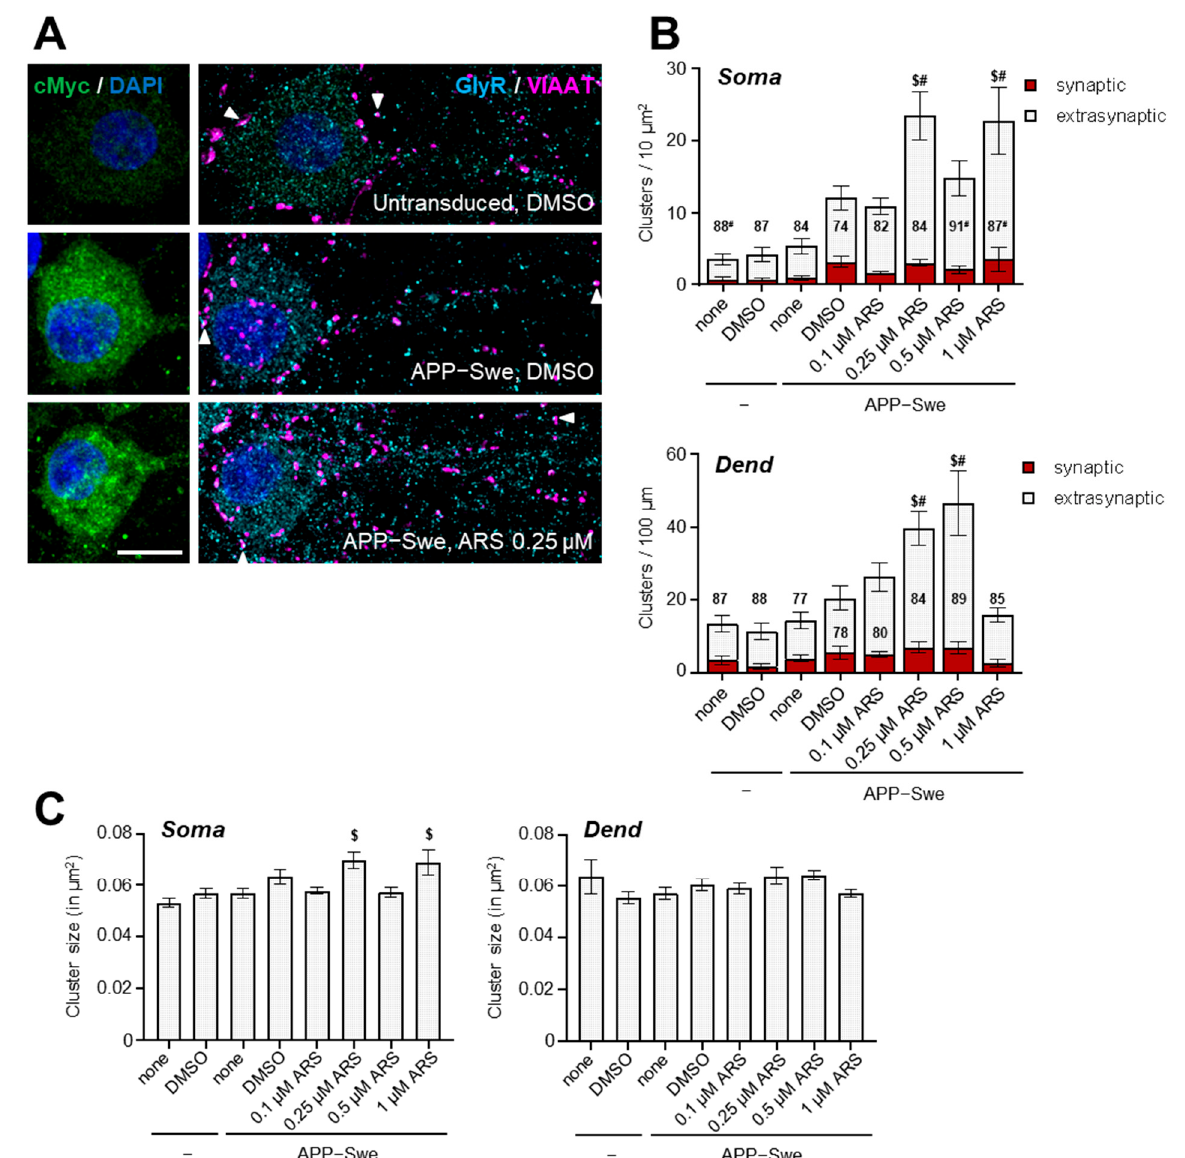
Figure 6. The effects of APP-Swe overexpression and artesunate treatment on GlyR clusters in dissociated hippocampal neurons. ( A ) Representative IF images of transduced hippocampal neurons of selected groups. cMyc-tagged APP-Swe transduced cells were manually selected for analysis based on cMyc immunofluorescence. Regions of interest encompassing either the entire soma or the proximal dendrite were selected and analyzed. The presence of synaptic (overlapping with presynaptic VIAAT signal) and extrasynaptic GlyR clusters (no overlap) can be clearly seen, as well as diffuse cytoplasmatic staining. ( B ) Quantification of the density of GlyR clusters at both the somatic (upper graph) and proximal dendritic (lower graph) compartments. Clusters were subdivided in putative synaptic (red bars) and extrasynaptic (light grey bars). GlyR clusters based on their overlap with the VIAAT signal. The numbers represent the percentage of extrasynaptic clusters from total clusters counted. Note a statistically significant increase in extrasynaptic cluster density for 0.25 and 1 µM artesunate for the somatic compartment, and for 0.25 and 0.5 µM artesunate for the dendritic compartment. Additionally, the percentage of extrasynaptic clusters was statistically significantly increased for the same artesunate dosages in the somatic compartment. ( C ) Quantitative analysis of cluster size. Note a statistically significant increase in cluster size for the 0.25 and 1 µM artesunate treatments in the somatic compartment only. Results are depicted as mean ± SEM. n = cells (22–24 per group). # p < 0.05 compared to APP-Swe-DMSO, $ p < 0.05 compared to untransduced-DMSO (one-way ANOVA with Sidak’s multiple comparison tests).